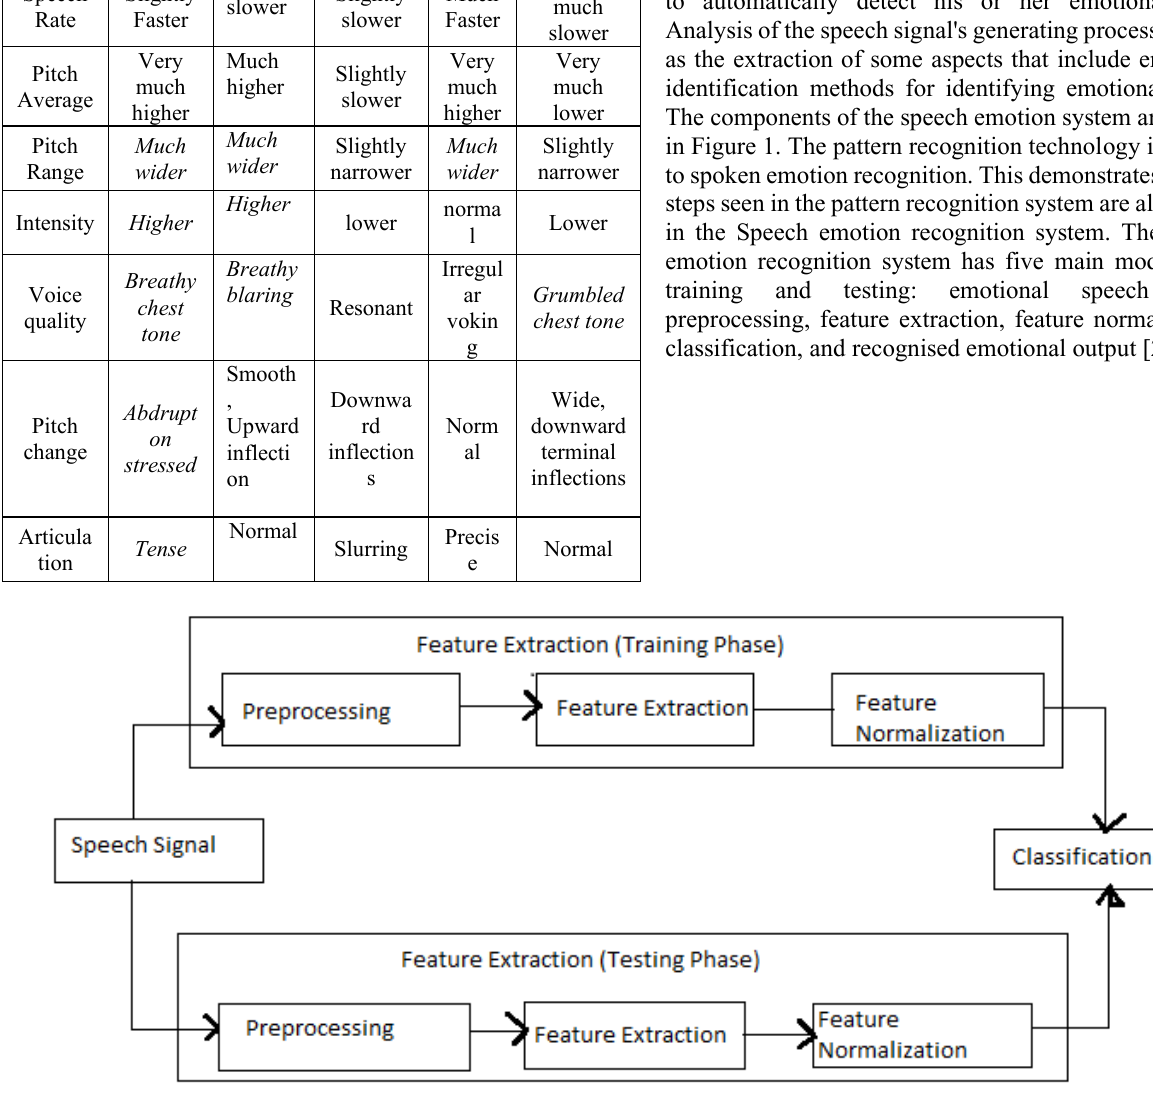
Fig. 1. Basic Emotion Recognition system